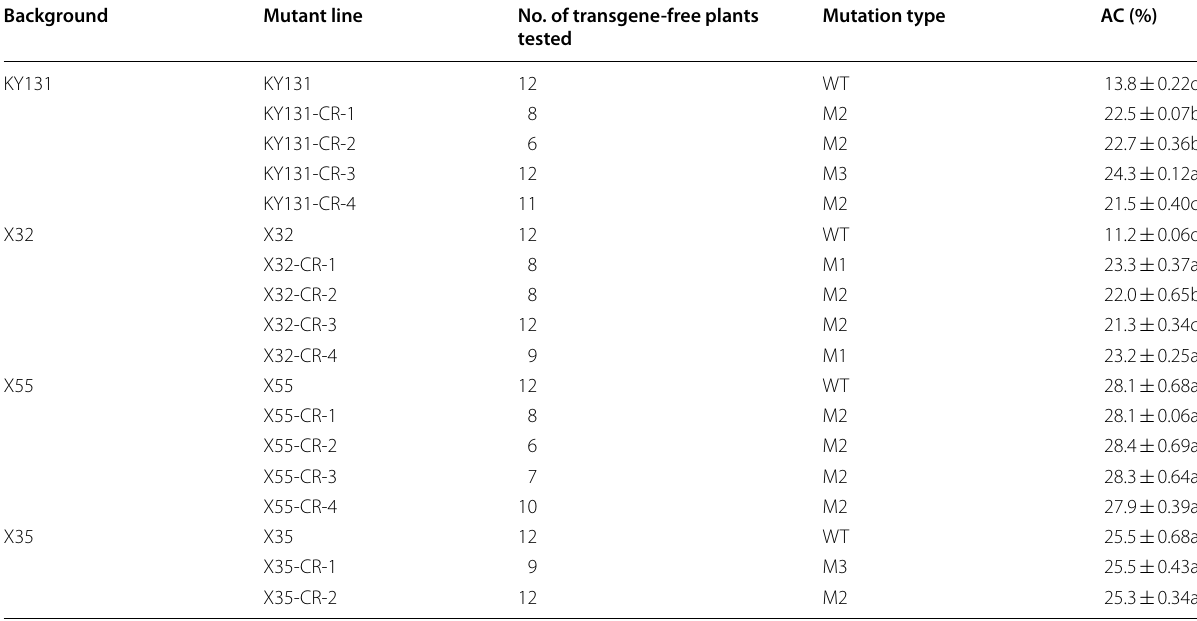
M1, M2, M3 represent mutants with 1041 bp, 1042 bp, 1043 bp deletion, respectively (Fig. 1D). AC values reported are mean mean values stands indicate significant differences ( P < 0.05)